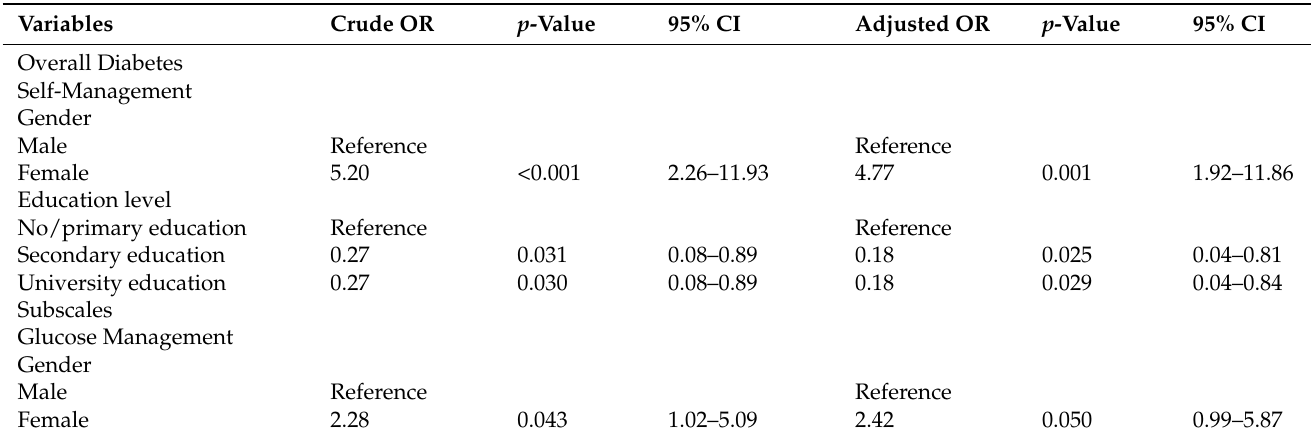
Table 5. Multivariable logistic regression analysis of diabetes self-management among diabetic participants attending PHCC in